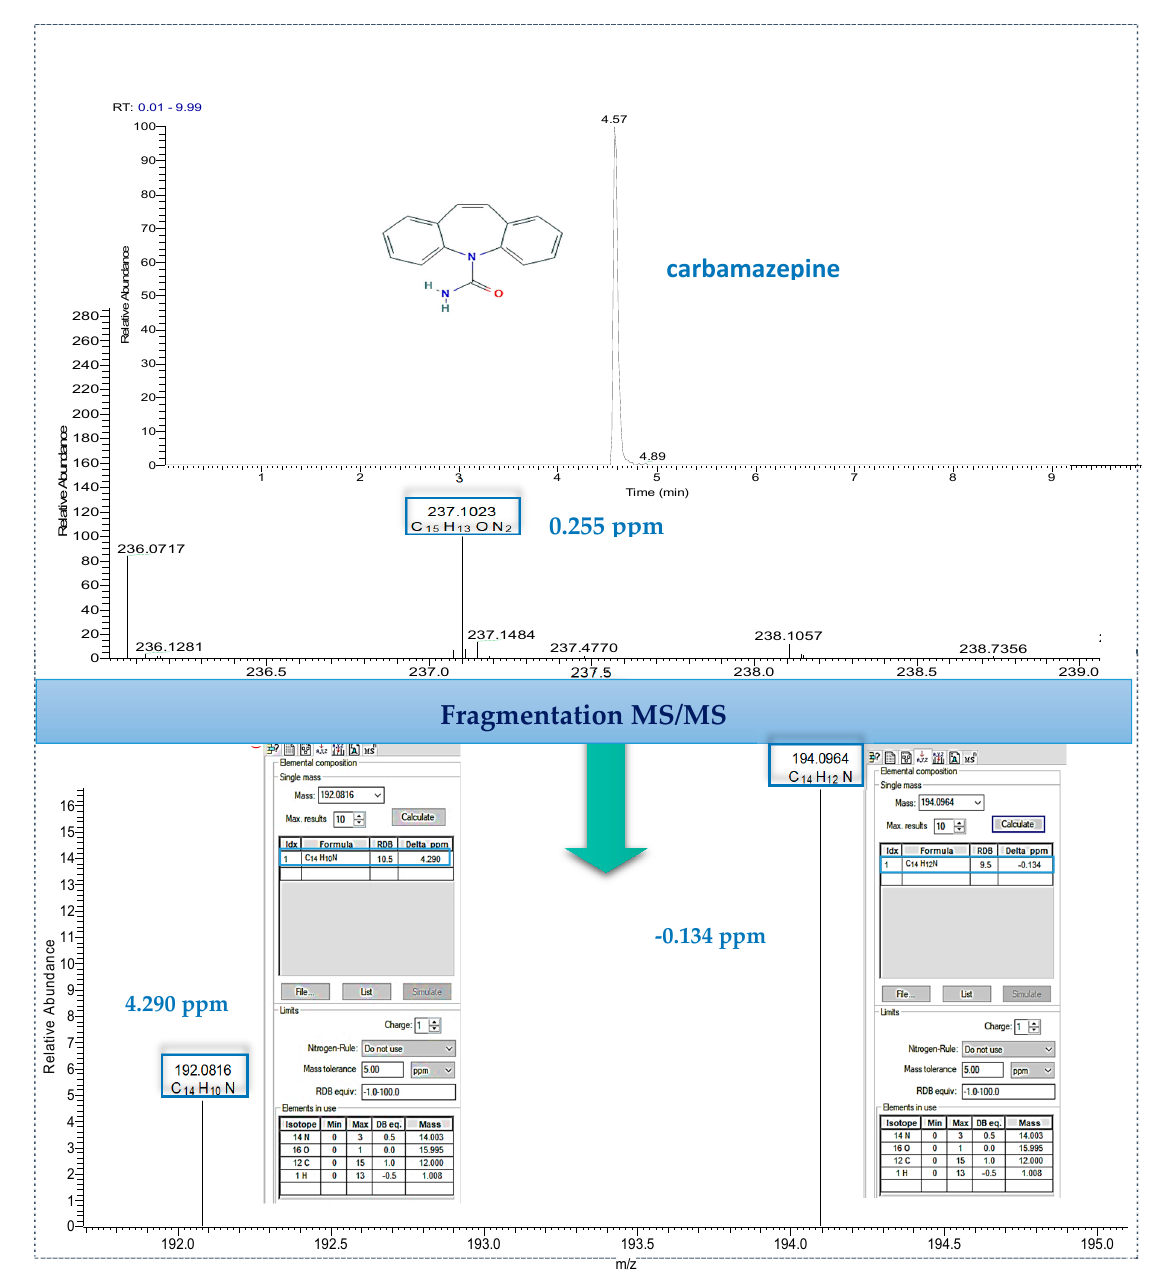
Figure 4. Identification of carbamazepine in effluent wastewater by performing UHPLC–LTQ Orbitrap tandem mass spectrometry fragmentation.